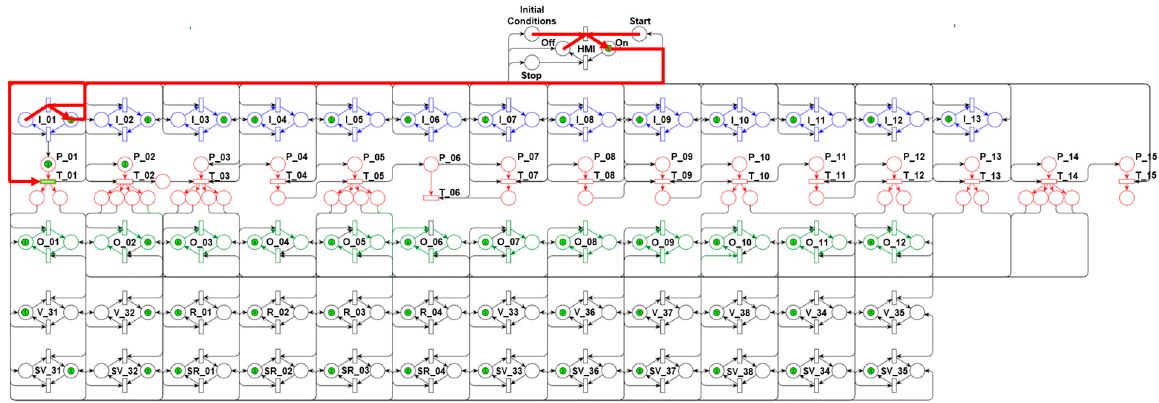
Figure 9. Algorithm’s first step—Start simulation.